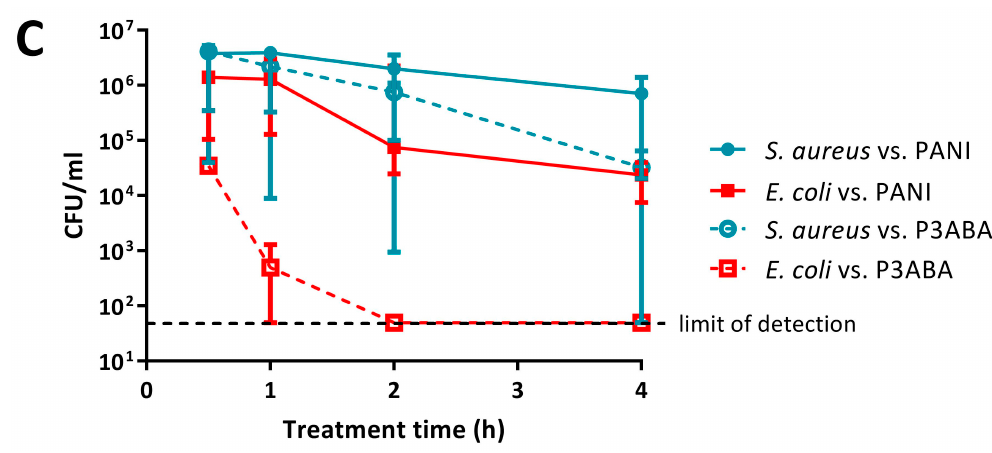
Figure 2. Sensitivity of E. coli 25922 lux and S. aureus 6538 to PANI and poly(3-aminobenzoic acid) (P3ABA) suspensions. Cell viability assays of ~10 6 CFU/mL E. coli and S. aureus treated with 0.5% PANI suspension ( A ) and 0.5% P3ABA suspension ( B ) in Lennox broth (LB), with each symbol representing the median of three technical replicates and the bar representing the median of each biological replicate. The data in A and B is replotted together in ( C ) where each point represents the median of biological replicates and the error bars are the range Viable cell counts (colony forming units (CFU)/mL) were obtained for each strain at 0.5 h, 1 h, 2 h, and 4 h time points. The limit of detection is 50 CFU/mL.